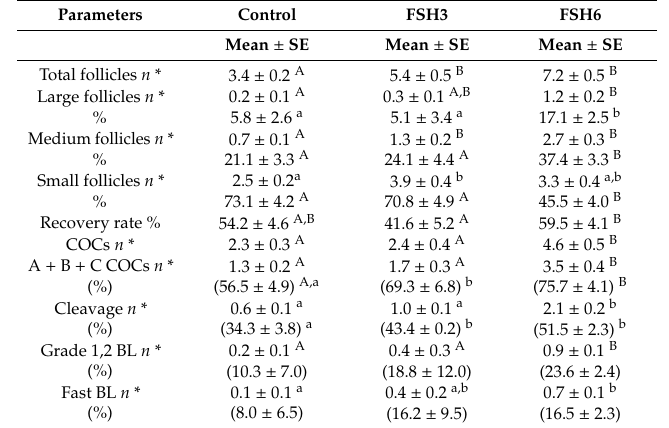
Table 1. E ff ect of follicle-stimulating hormone (FSH) priming with either three doses (FSH3) or six doses (FSH6) on follicular population, oocyte quality, and developmental competence parameters compared to